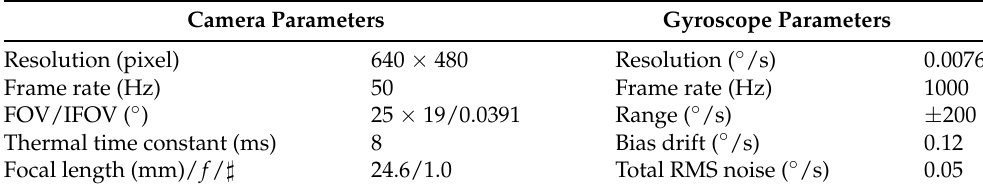
Table 1. The Parameters of Camera-Gyroscope integrated system.